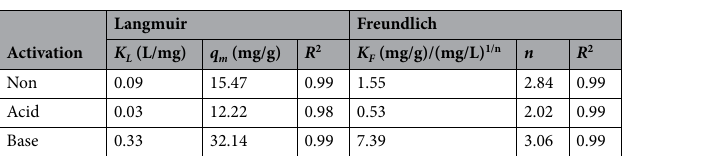
Table 2. Langmuir and Freundlich model parameters for Cs adsorption on each activated opaline mudstone.